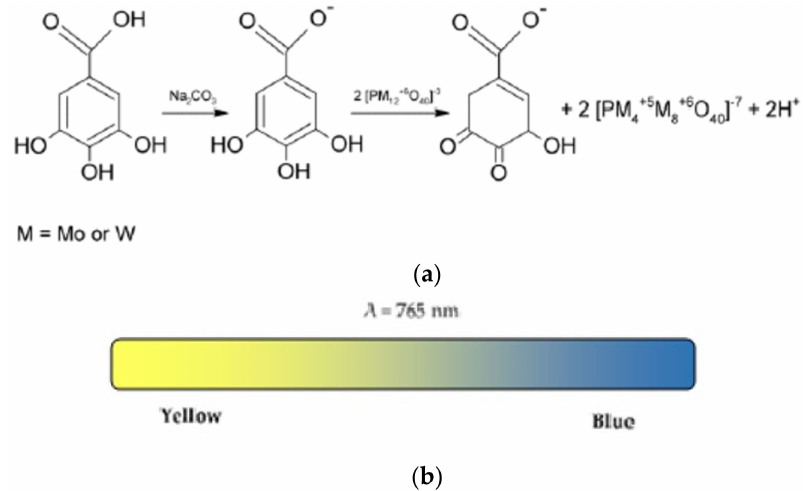
Figure 7. Reaction between the phenolic compounds and the derivatives of the phosphotungstic and phosphomolybdic acids in an alkaline environment, resulting in the formation of a blue colour by the Folin–Ciocalteu method ( a ); Colour variation observed in the assay ( b ).